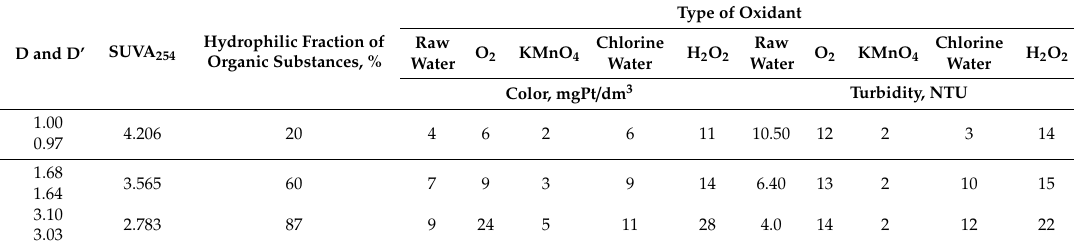
Table 5. The influence of the type of oxidant, values of the coe ffi cients D (TOC / Fe tot ) and D’ (DOC / Fe tot ) and the SUVA 254 on the real color and turbidity in water after oxidation and sedimentation processes. Type of Oxidant Hydrophilic Fraction of Chlorine Raw O 2 KMnO 4 D and D’ SUVA 254 Organic Substances, % Water